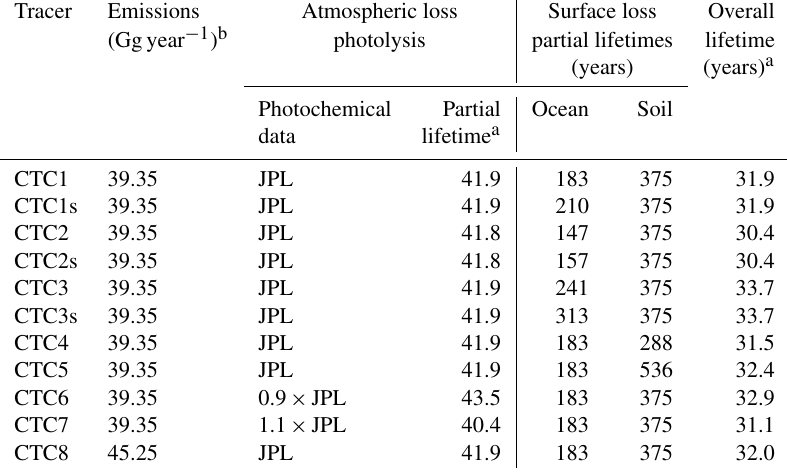
Table 2. Summary of the TOMCAT 3-D CTM simulated CCl 4 tracers.